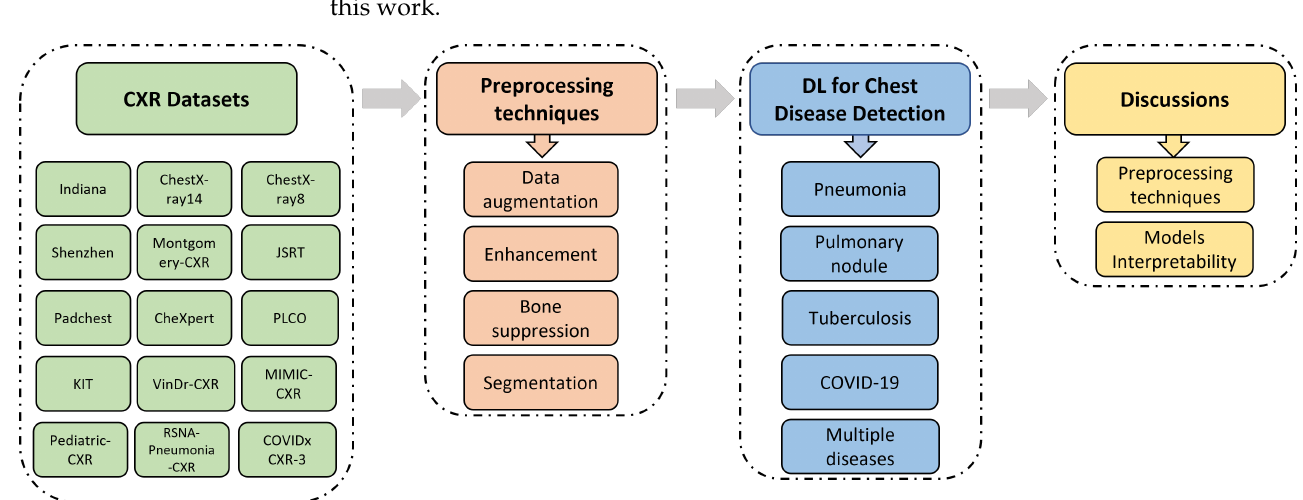
Figure 1. Structure diagram illustrating the topics discussed in our